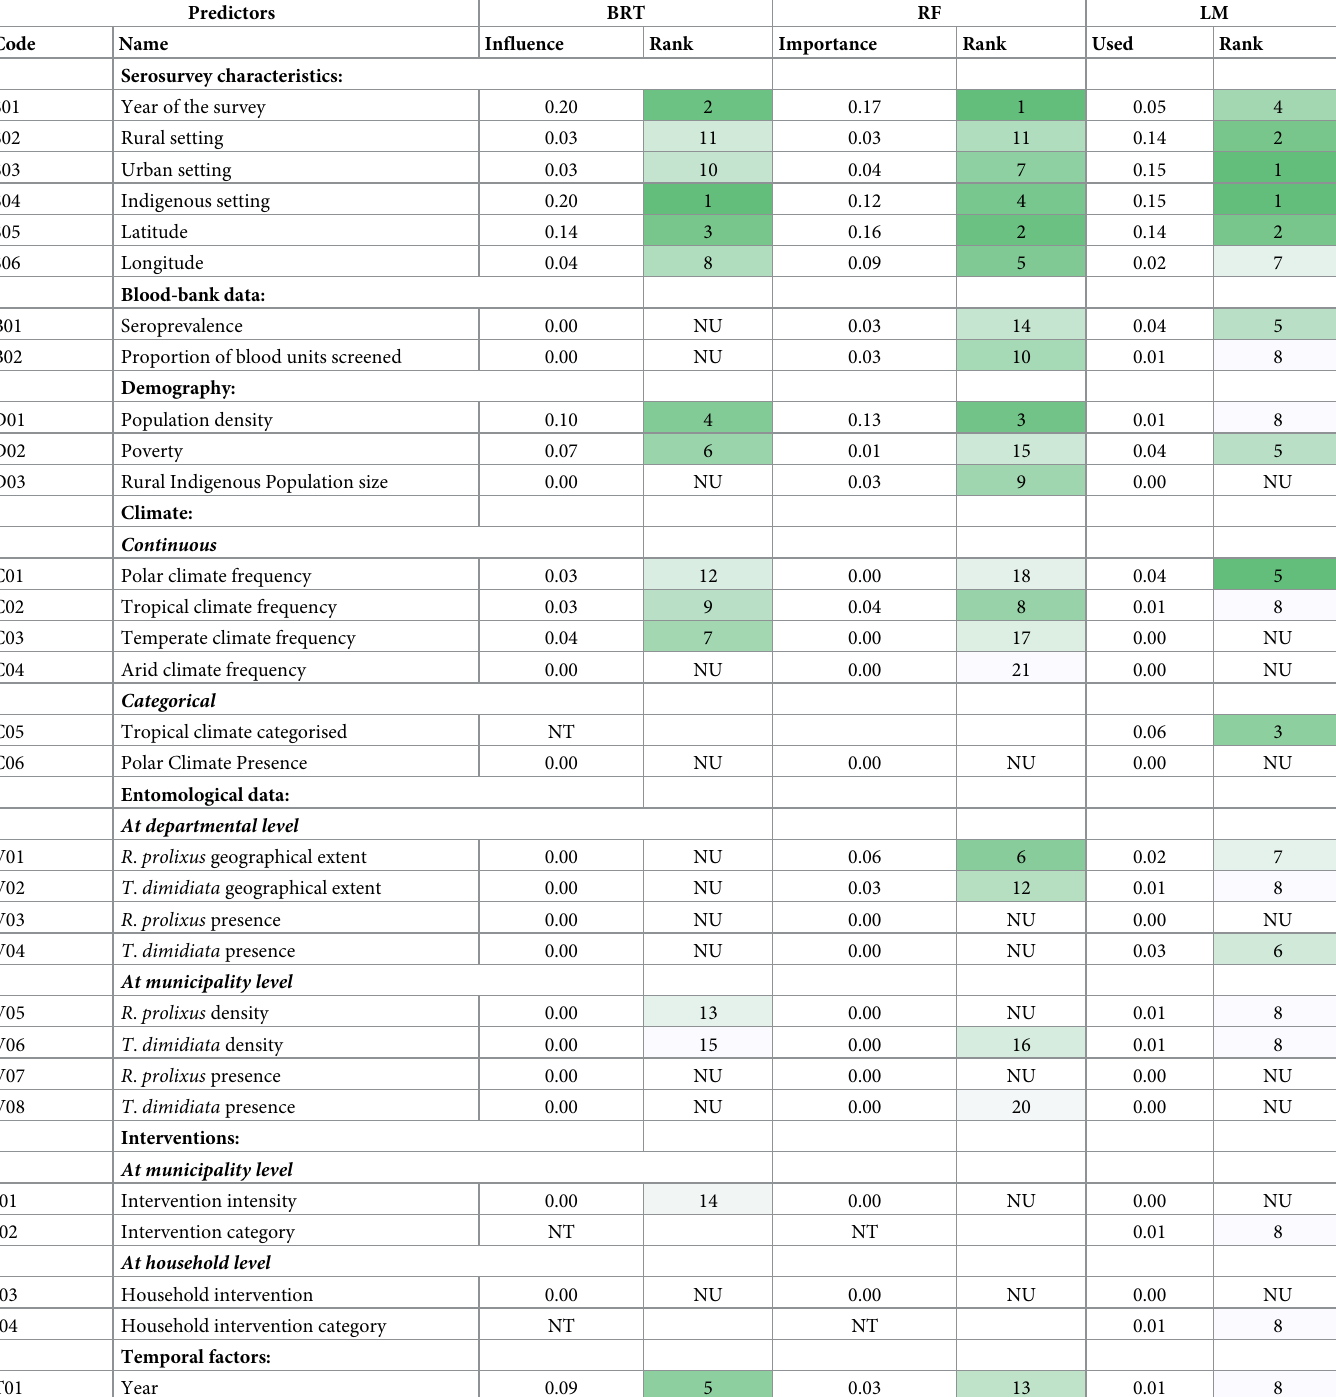
Table 2. Standardized relative influence, importance and rank of the predictors included in Boosted Regression Trees (BRT) and Random Forest (RF) Machine Learning models and normalised number of times the predictors were used in the linear model (LM) framework and their rank when using the full posterior distri- bution of FoI